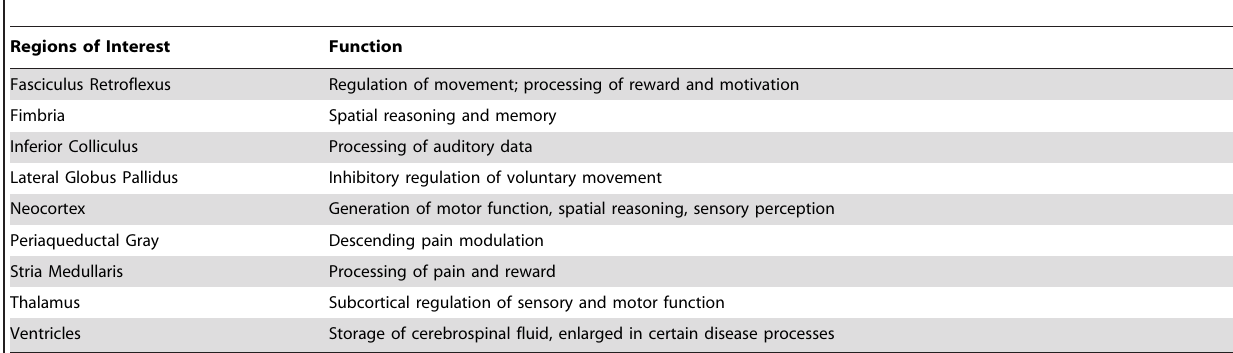
Table 2. Functions of Brain Regions with Significant Volume Changes Seen in MRI Imaging of Adult Mouse